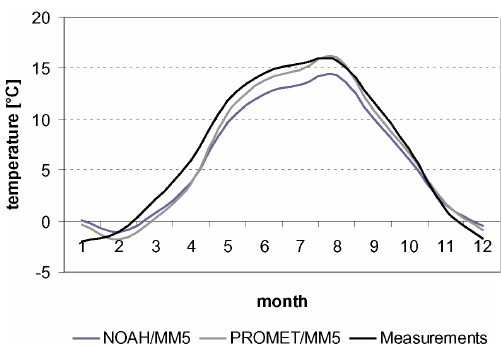
Figure 4: Monthly course of the total incoming short-wave radiation (1996-1999) of 2-way Fig. 4. Monthly course of the total incoming short-wave radiation coupled PROMET/MM5 and Noah/MM5 simulations. (1996–1999) of 2-way coupled PROMET/MM5 and NOAH/MM5 Temperature simulations.